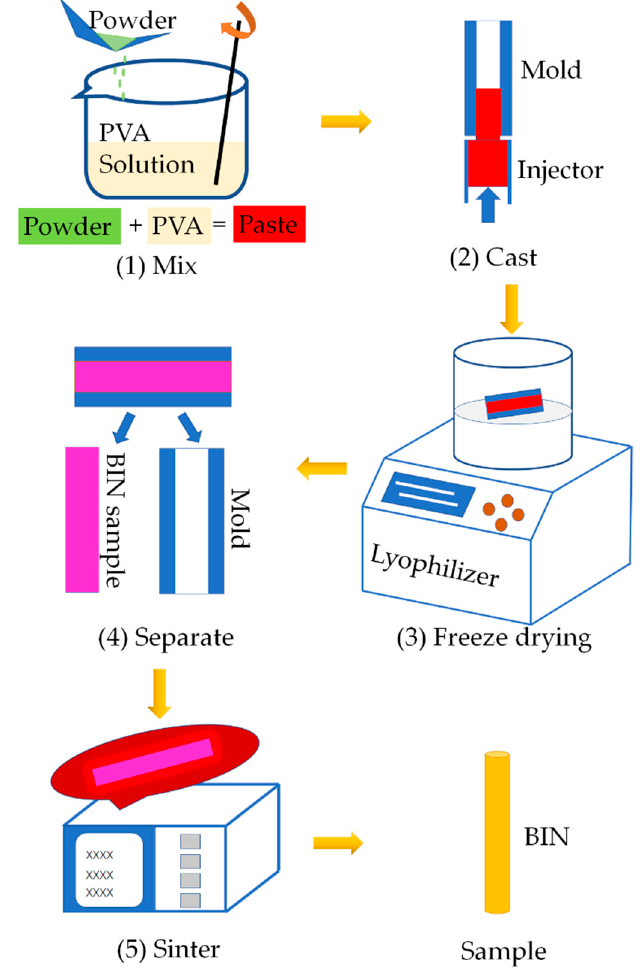
Figure 1. Schematic illustration of the manufacturing process of BINs. ( 1 ) Mixing CSi-Mg powders with PVA solution. ( 2 ) Pouring the paste into the hollow glass tube mold. ( 3 ) Freeze drying. ( 4 ) Demolding. ( 5 ) Sintering. Crystals 2022 , 12 , x FOR PEER REVIEW